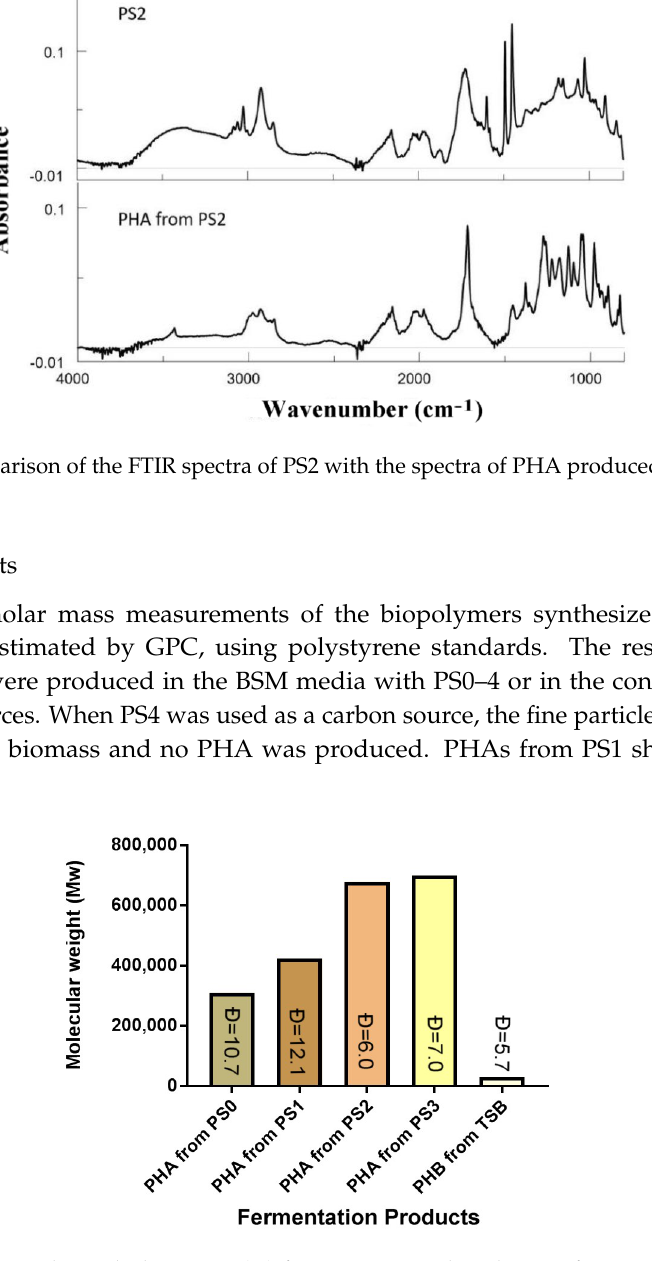
Figure 8. The GPC results with dispersity ( Ð ) from PHAs produced. PHB from TSB (control) and PS0–3 samples as additional carbon sources with TSB (nitrogen rich) media. No PHAs were produced in